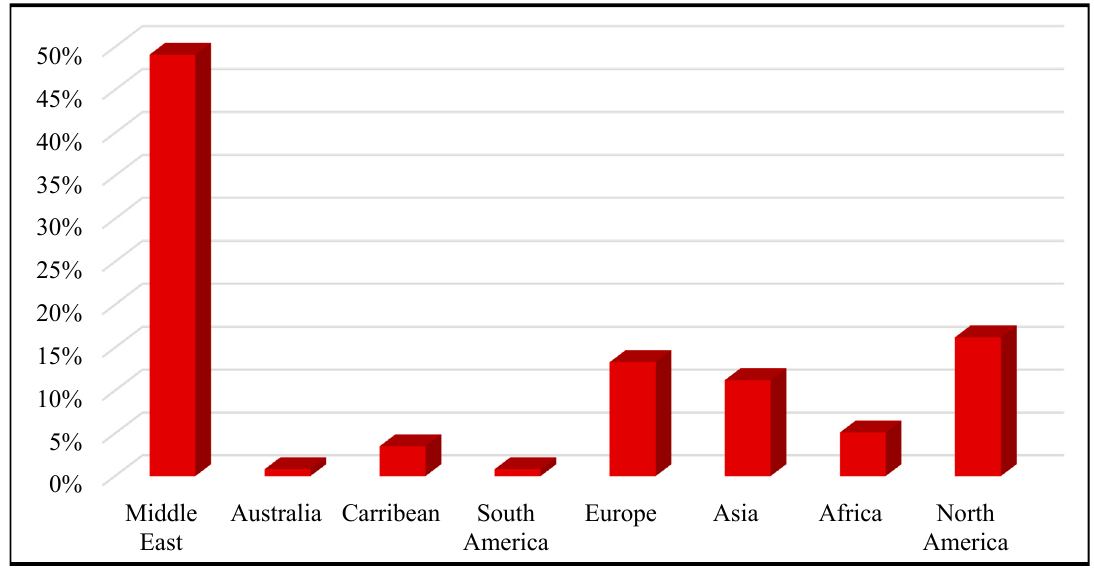
Figure 1. The desalination capacity worldwide, shown on the basis of region